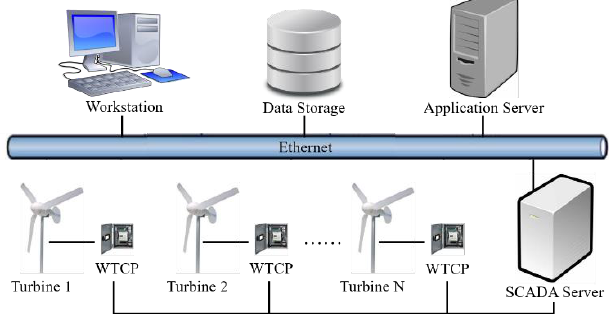
Figure 1. Representative architecture of wind farm supervisory control and data acquisition (SCADA) system.